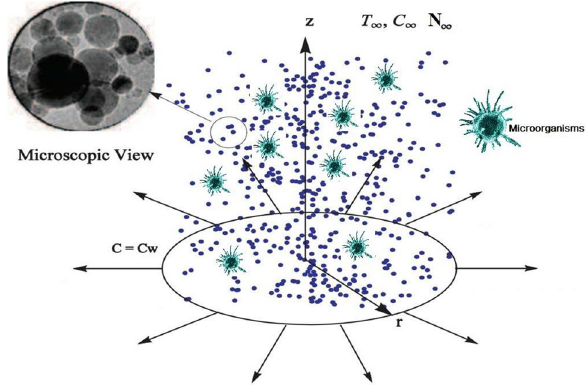
Figure 1. Flow configuration with motile